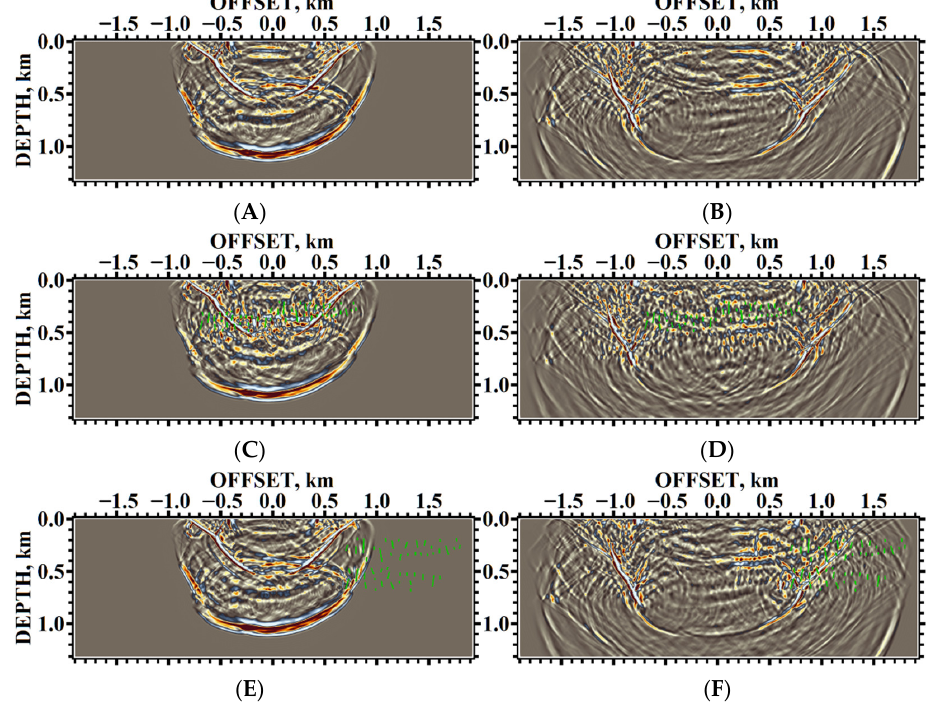
Figure 35. Example #5, vertical component of velocity snapshot: ( A , B ) «without fractures», time of 0.275 s ( A ) and time of 0.51 ( B ); ( C , D ) «fractured zone #1», time of 0.2784925 s ( C ) and time of 0.516477 ( D ); ( E , F ) «fractured zone #2», time of 0.2695 s ( E ) and time of 0.4998 s ( F ). The source was a Ricker wavelet with a frequency of 30 Hz, marked by the red dot